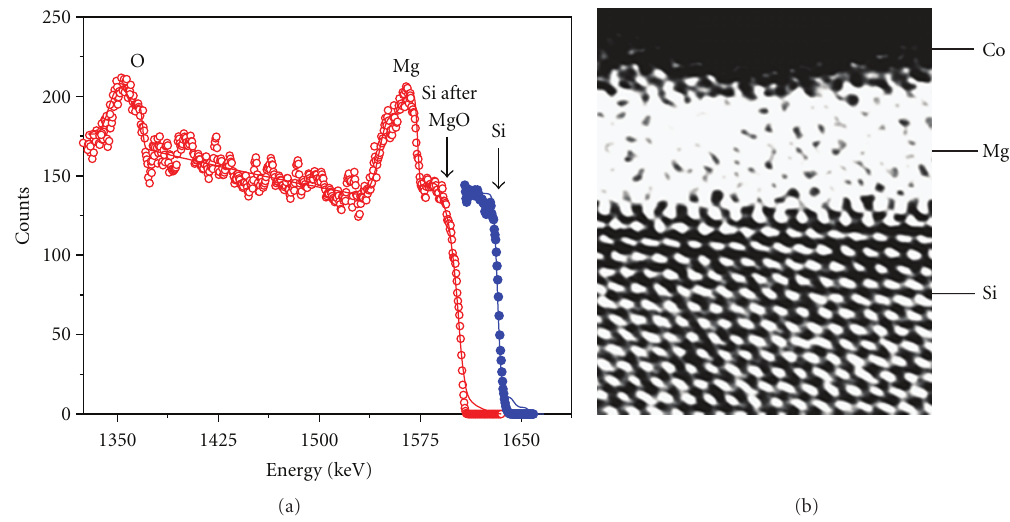
Figure 9: (a) HRBS spectra of a Si sample before and after MgO evaporation. Before evaporation: HRBS spectrum of the high-energy edge Si edge (solid circles) and RUMP simulation (solid line) of the clean Si. After MgO evaporation: HRBS spectrum at Si, Mg and O edges (open circles) and RUMP simulation (solid line) of the 23ML MgO as prepared on a Si (100) surface. (b) HR-TEM cross-sectional micrograph of a Si (100)/MgO (23 ML)/Co